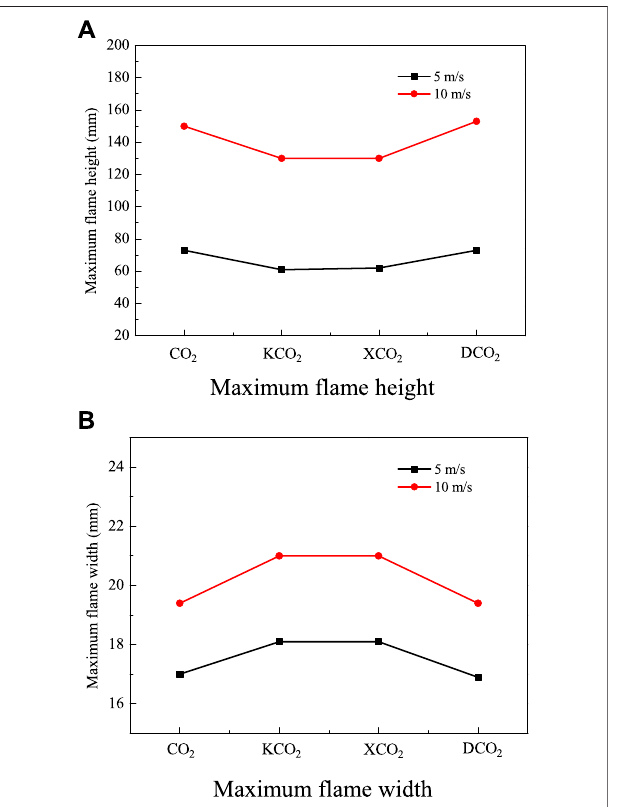
FIGURE 9 | Computational fl ame height and width based on OH distributions in laminar non-premixed CH 4 jet fl ames in different oxidizers. (A) Maximum fl ame height. (B) Maximum fl ame width.